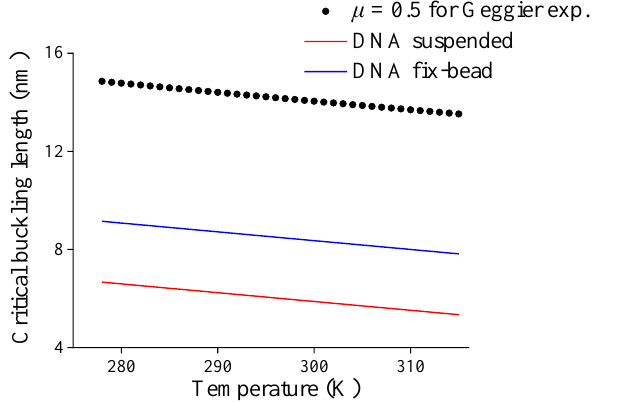
Figure 5. Critical buckling length of DNA fragment with different end-constraints versus temperature. Second, it is assumed that the gradient of buckling length varying with temperature in Equation (11), i.e., − 0.0359 nm/K, is also applicable for other mechanical end-constraints. The average critical buckling lengths 5.95 nm and 8.43 nm at 298 K listed in Table 2 and the obtained gradient are used to obtain the linear expression of DNA critical buckling lengths varying with temperature for DNA suspended in solution or with fix-bead constraint, respectively, i.e.,